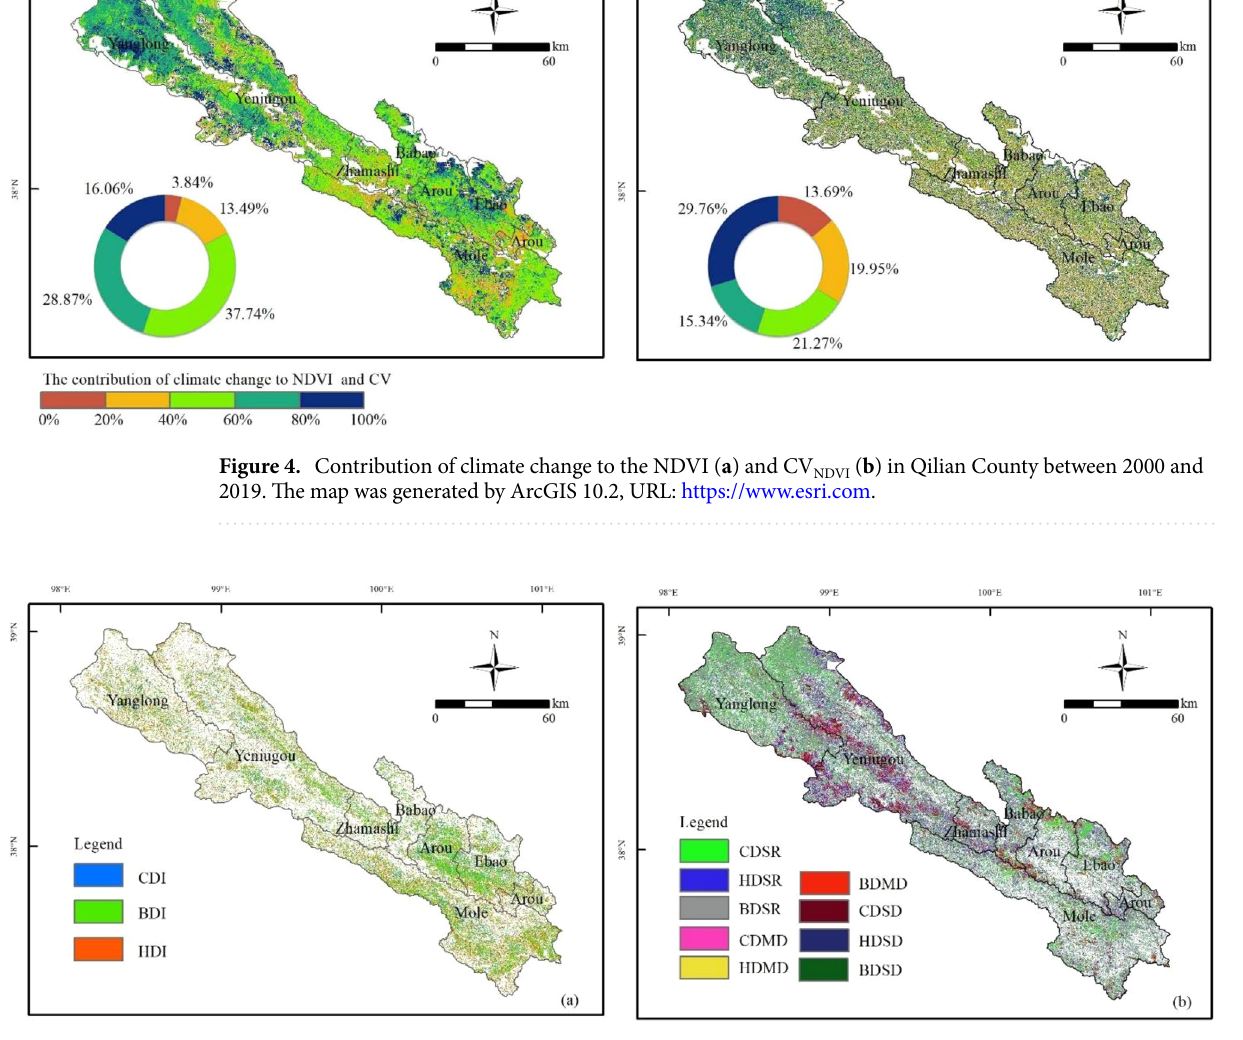
Figure 5. Effects of climate and human activities on grassland degradation ( b ) and restoration ( a ). The map was generated by ArcGIS 10.2, URL: https:// www. esri.